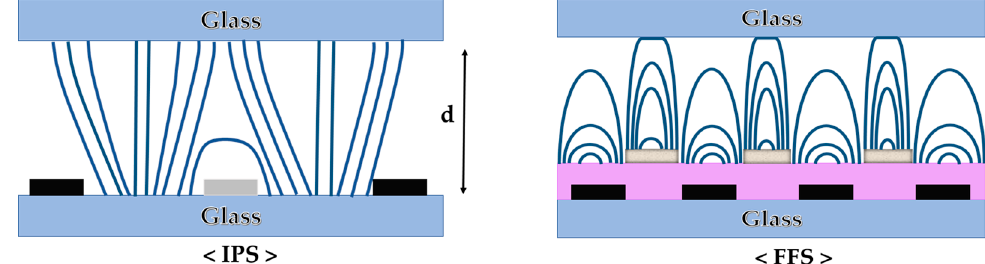
Figure 13. In-plane electrode configurations in an LC Cell: The black rectangle shows the metal electrodes, and the blue lines are equipotential lines generated by interdigital electrodes for in-plane switching (IPS) and fringe field switching (FFS) cells.